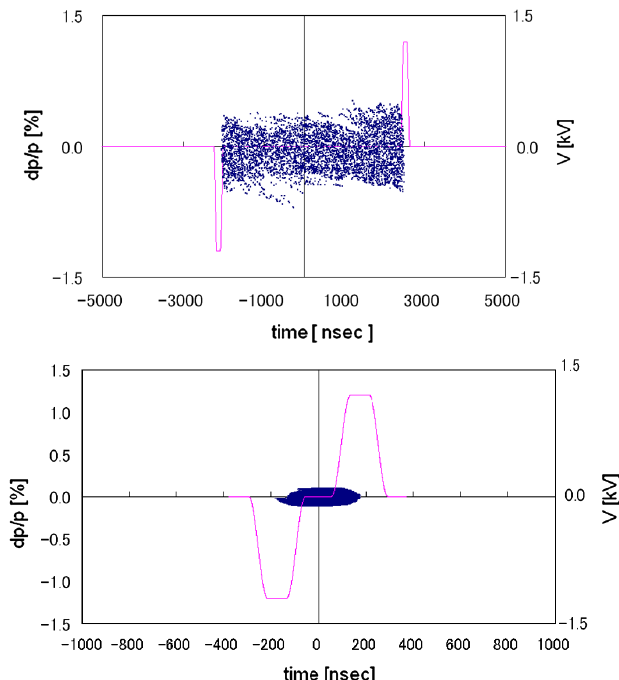
FIG. 34. Phase plot of an Ar 8 þ beam 100 turns after injection (top) and just before extraction (bottom). Dots show injected ions and the purple lines correspond to barrier voltages for confinement (unit: